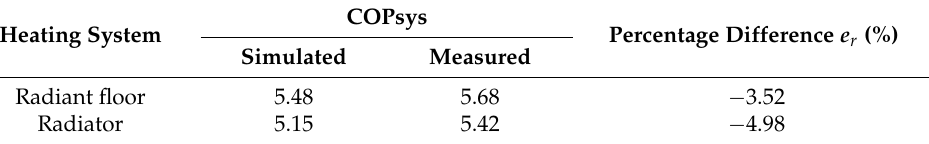
Table 4. The COP values for GCHP